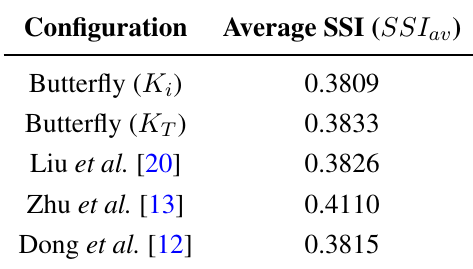
Table 2. Summary of similarity between